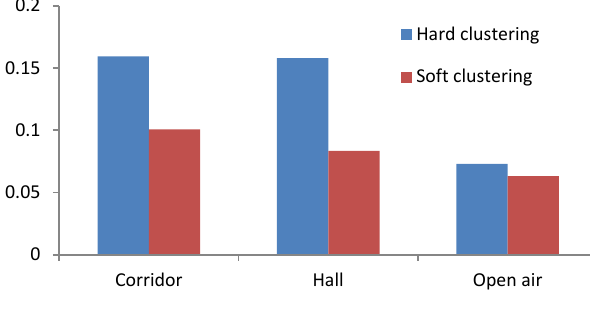
Figure 5. RSSI-D estimation error using interval data hard and soft clustering methods.